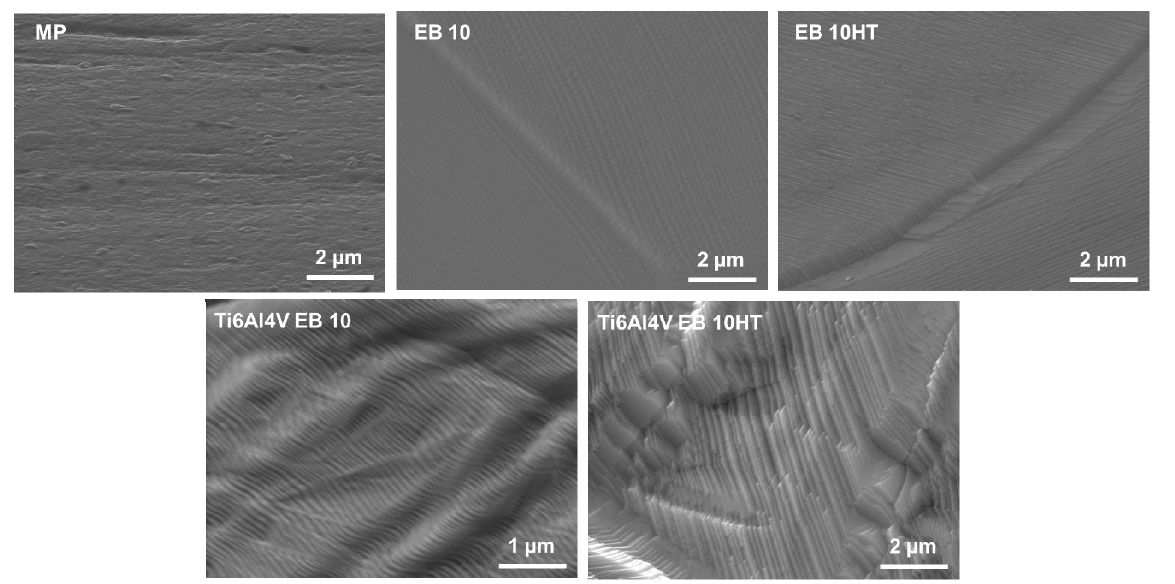
Figure 2. Detail of the nano topography at the surface of Ti15Mo (above) and Ti6Al4V (below) described in previous work [33].